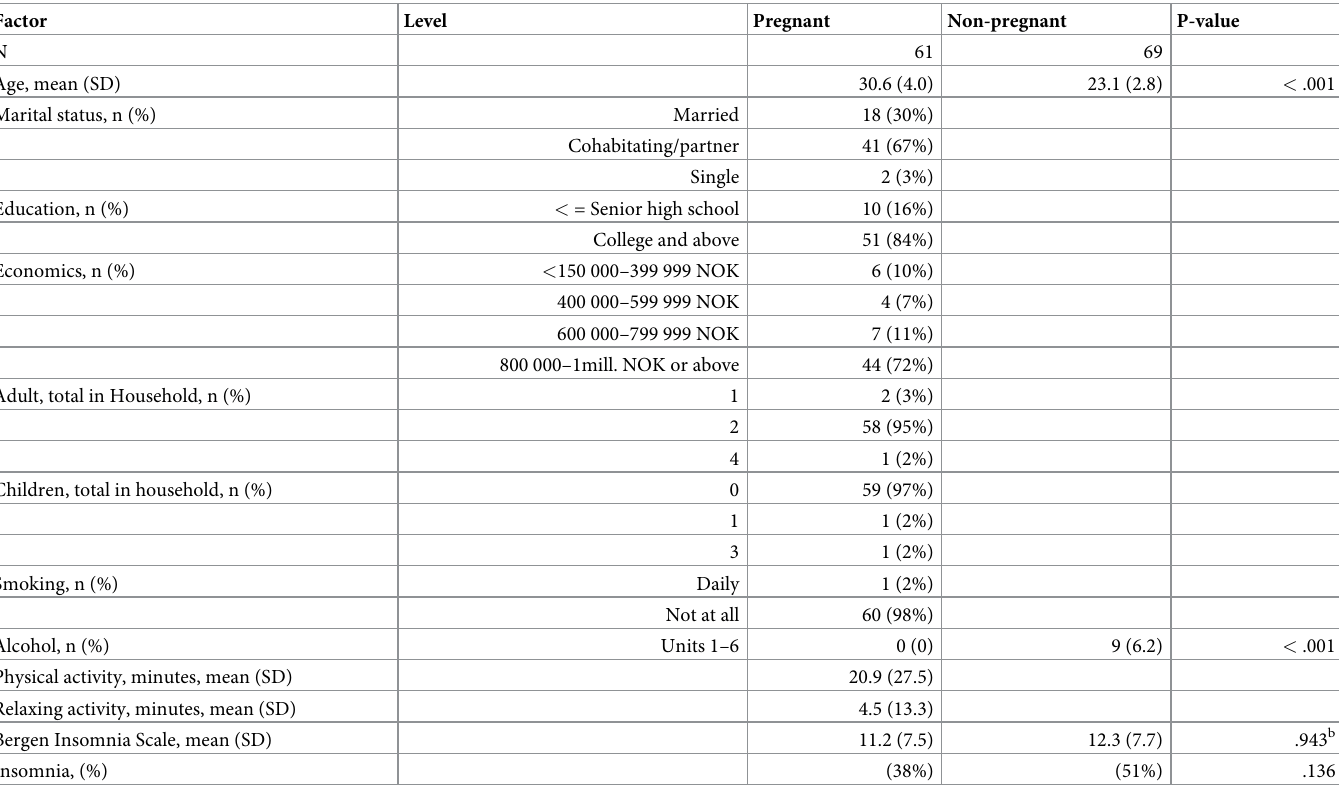
Table 1. Demographic factors among pregnant and non-pregnant women, self-reported